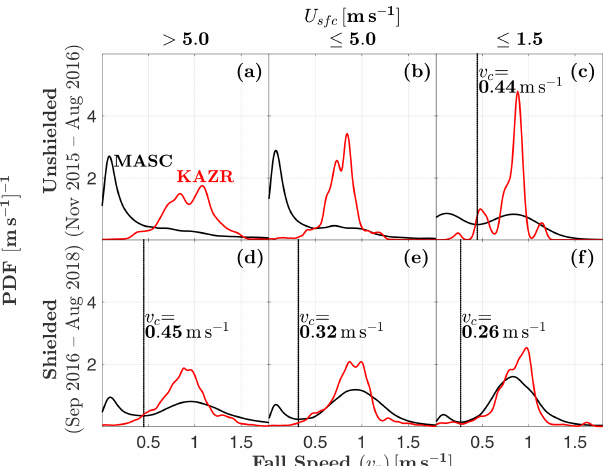
Figure 5. Comparison of MASC hydrometeor fall speed and KAZR mean Doppler velocity PDF estimates for (a–c) unshielded and (d– f) shielded MASC measurements. Surface wind speeds U sfc de- crease from left to right. Where MASC PDFs are bimodal, the ver- tical line marks the cutoff fall speed v c , indicating the location of the local minimum separating the two modes. The number of ob- servations for each case is listed in Table 1. The terms “shielded” and “unshielded” refer only to the MASC. Unshielded and shielded MASC observations are from two separate periods: 29 November 2015–21 August 2016 and 22 August 2016–28 August 2018, re- spectively.